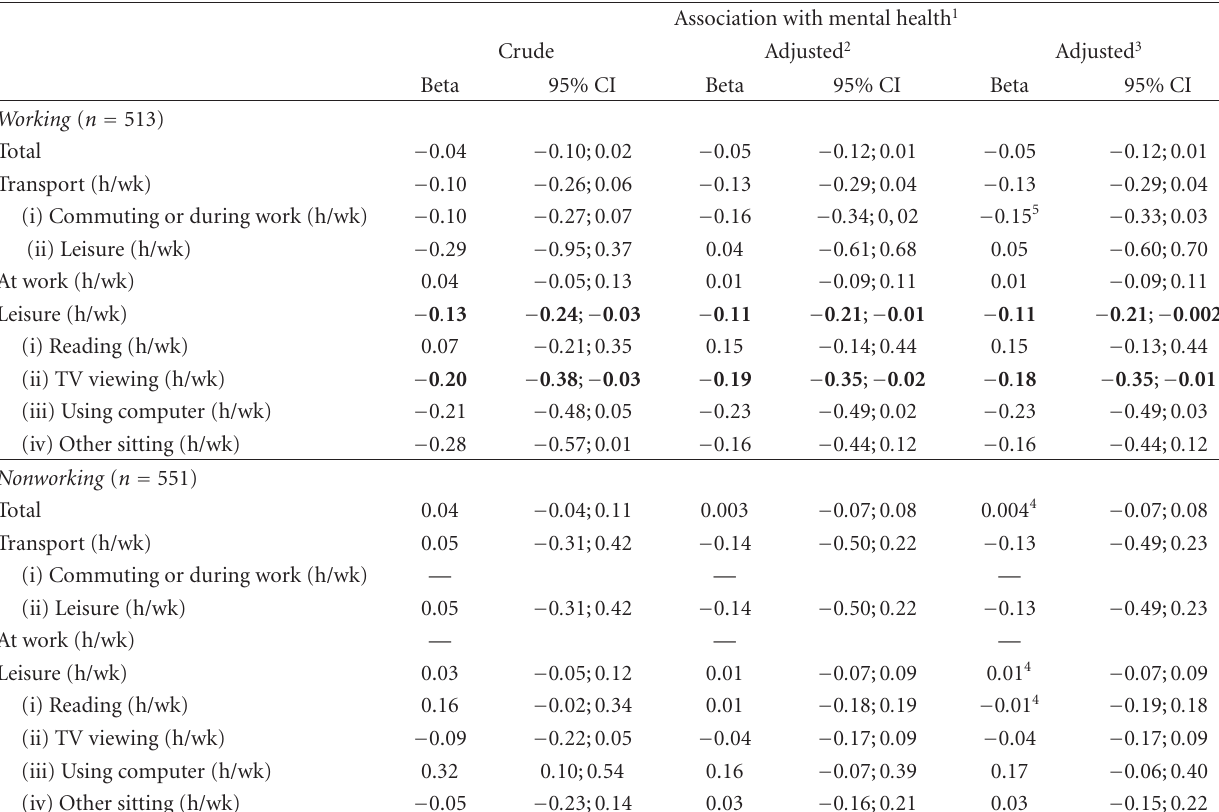
Table 2: The association between sitting time and mental health stratified by work status: results of the linear regression